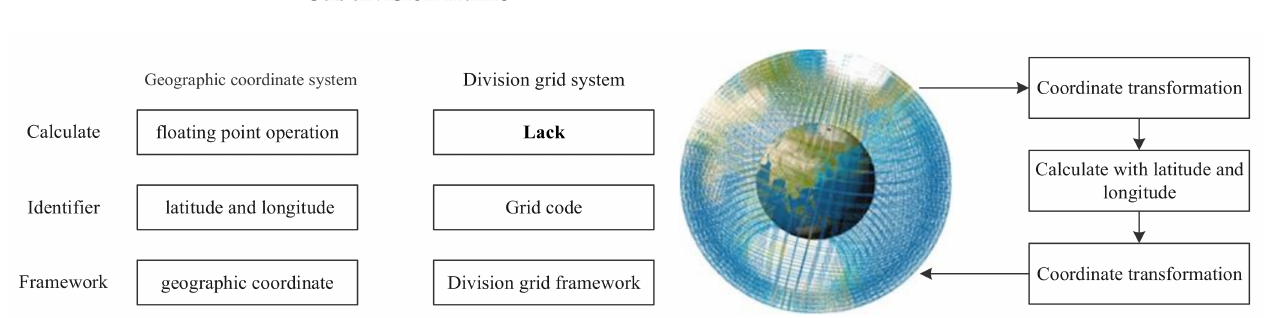
Figure 4. The current spatial operation mode of the subdivision data.